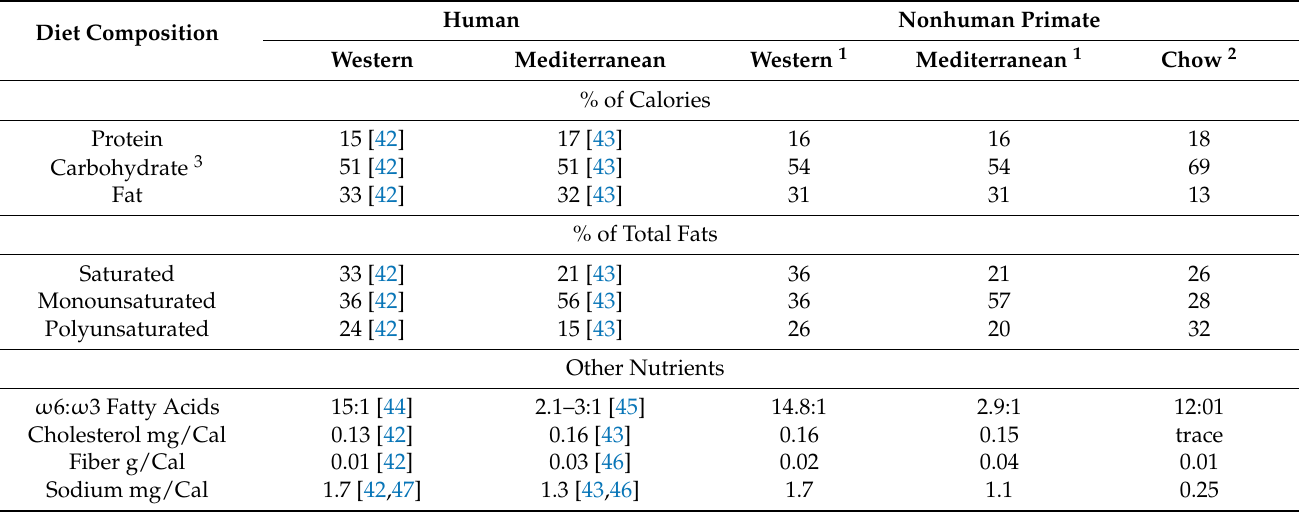
Table 1. Comparison of Nonhuman Primate Diet Compositions Used in the Current Study with Human Diet